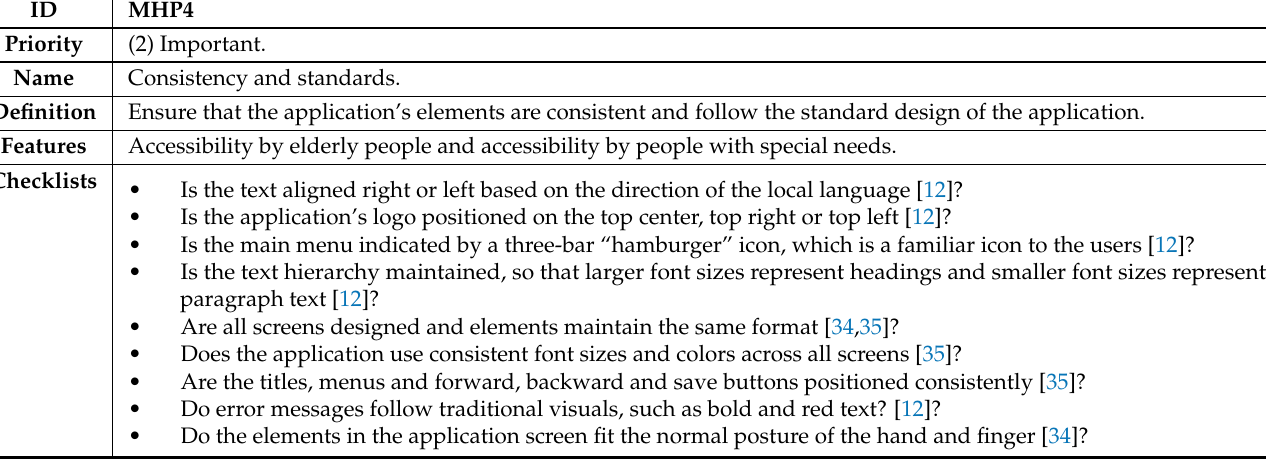
Table A4. Descriptive details of the fourth